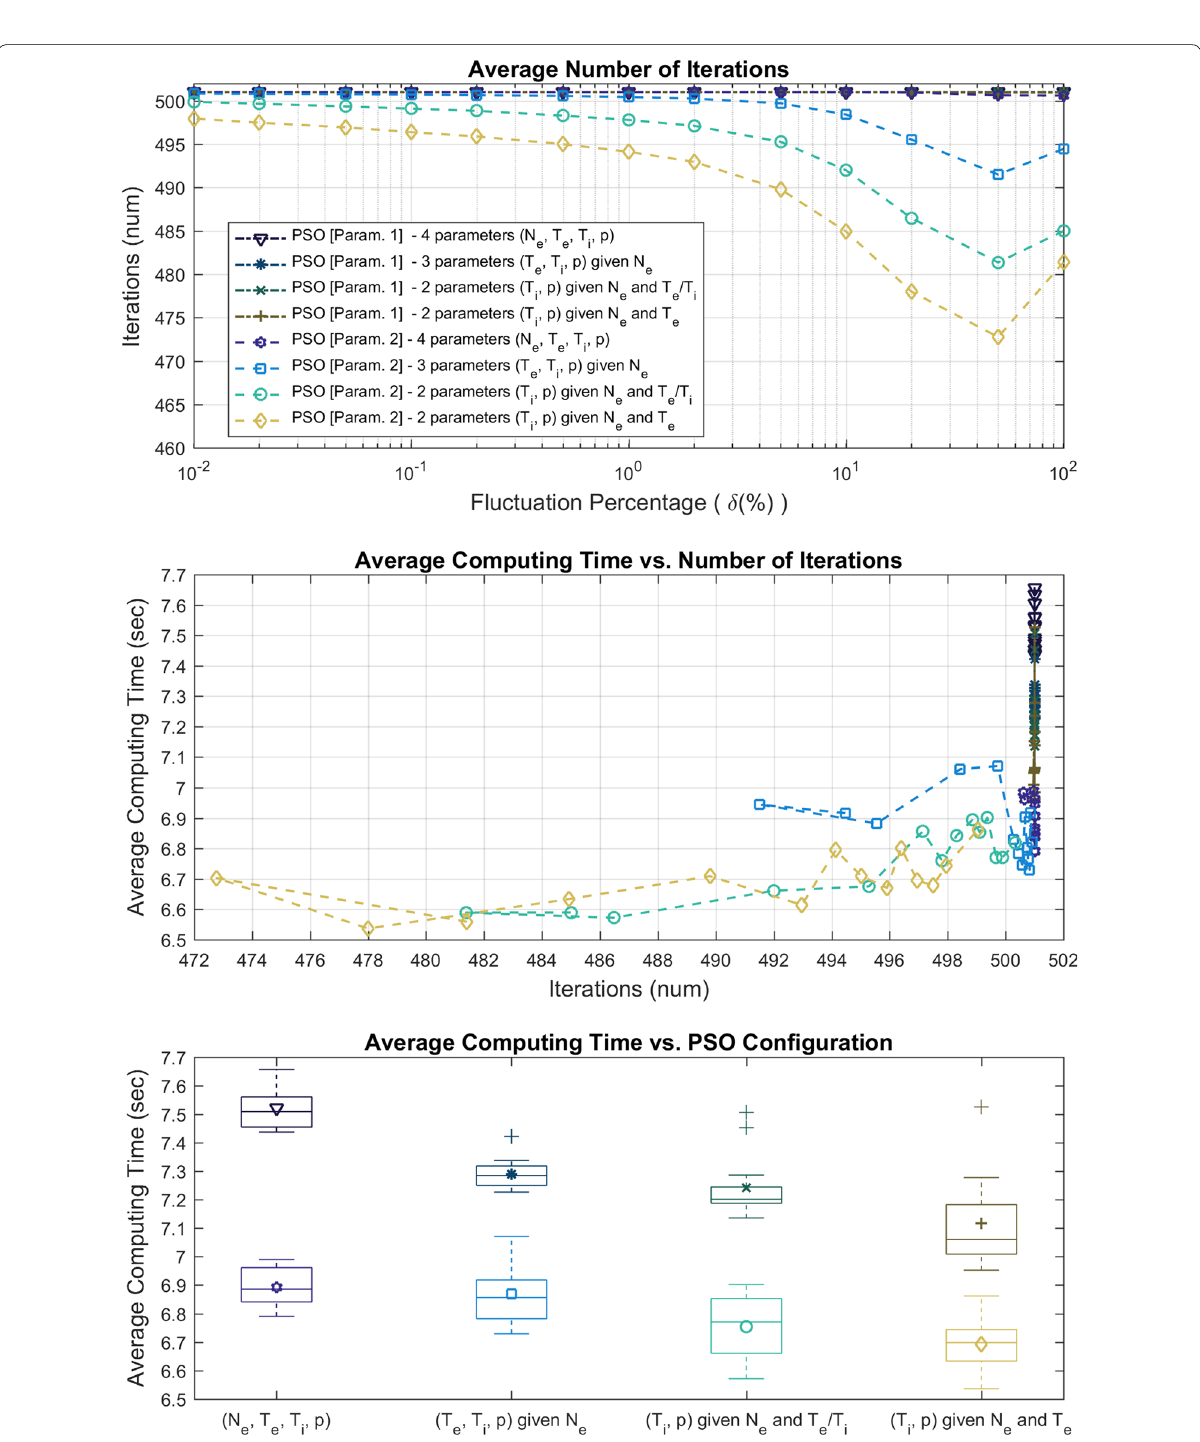
Fig. 8 (Top) Average number of iterations and (middle) corresponding computing times of the PSO algorithm estimating different combinations of known a priori plasma parameters from the plasma line at different signal fluctuation percentages ( δ( % ) ). Results were obtained from simulations with the parameter configuration (dash‑dotted lines) “Param. 1” used by Wu et al. (2015) and (dashed lines) “Param. 2”. (Bottom) Boxplot of average computing times of simulations with different combinations of a priori plasma parameters using the configurations “Param. 1” and “Param.